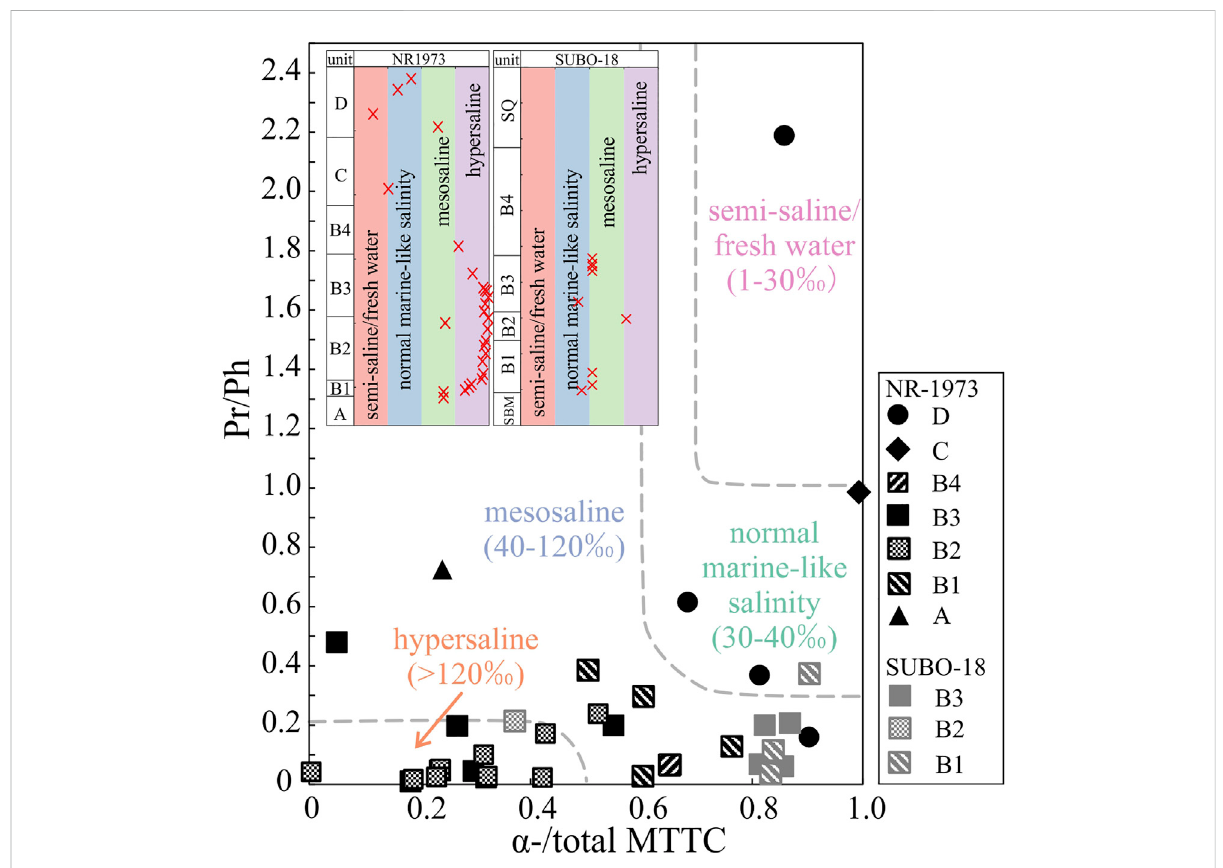
FIGURE 11 Crossplot of α -/total MTTC vsPr/Ph of thepost-impact sediments in the Nördlinger Ries (modi fi edafter Schwark et al., 1998; Wang et al., 2011; Jiang et al., 2019). See Figure 2 for stratigraphic